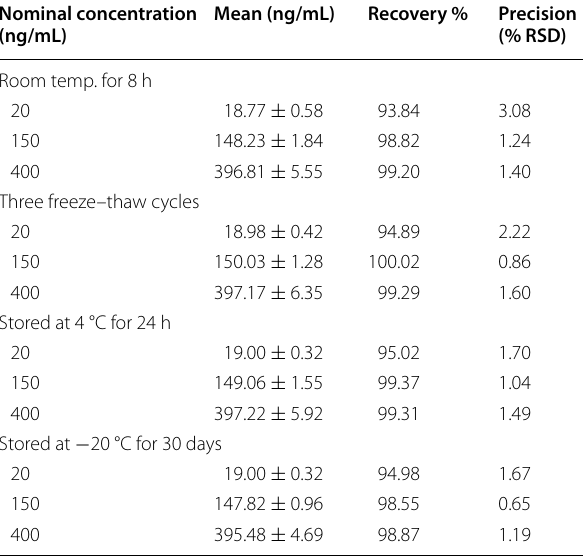
Table 4 VNT stability data in plasma matrix under differ-